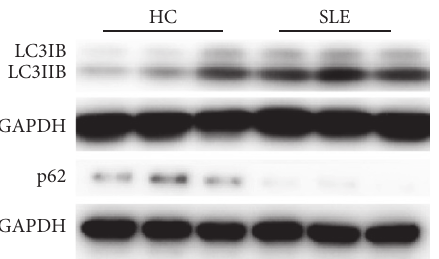
Figure 1: T cells from SLE patients had overactivated autophagy. CD3+T cells were purified from peripheral blood mononuclear cells (PBMCs). T cells from SLE patients had higher expression of LC3IIB and lower p62 than that from healthy controls